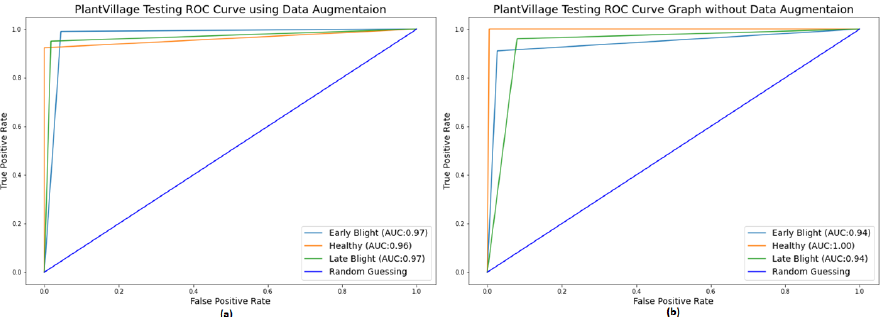
Figure 16. ( a ) PDDCNN ROC Curve on PlantVillage withaAugmentation. ( b ) PDDCNN ROC Curve on PlantVillage without